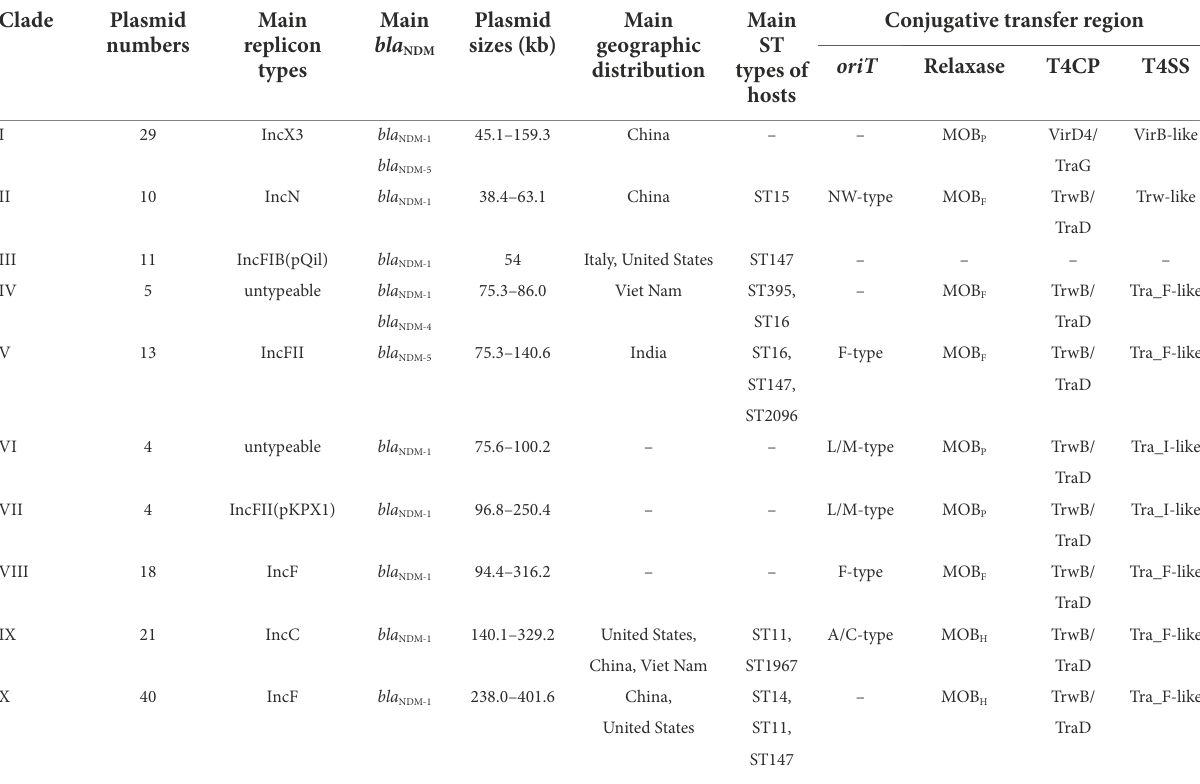
TABLE 1 Summary of the 171 bla NDM -harboring plasmids of Klebsiella pneumoniae.